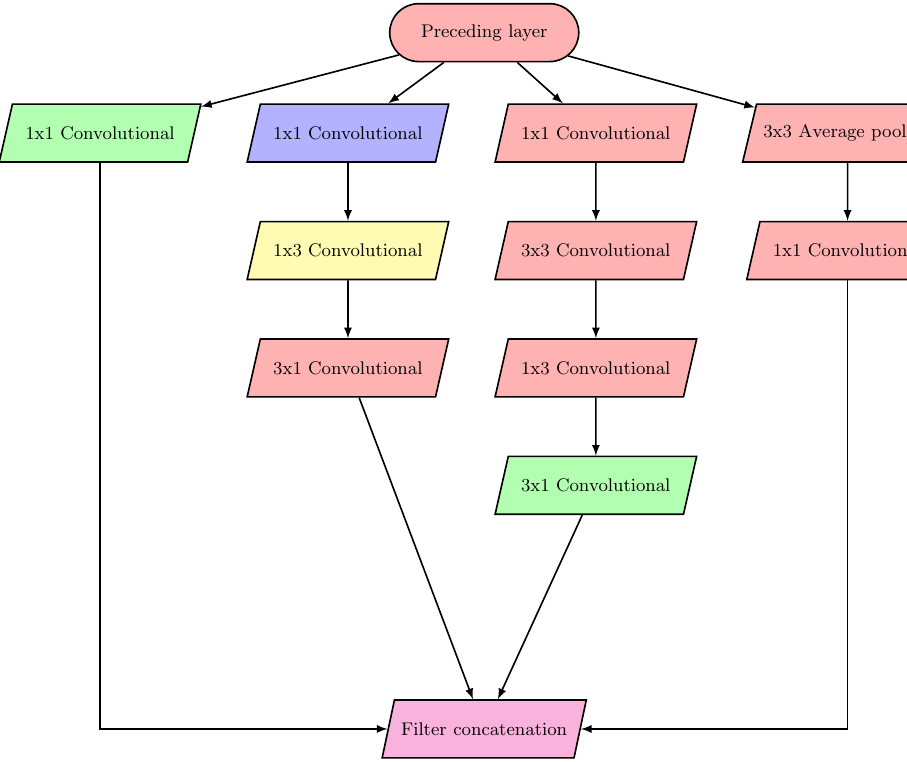
Figure A2. Block diagram of Inception III.